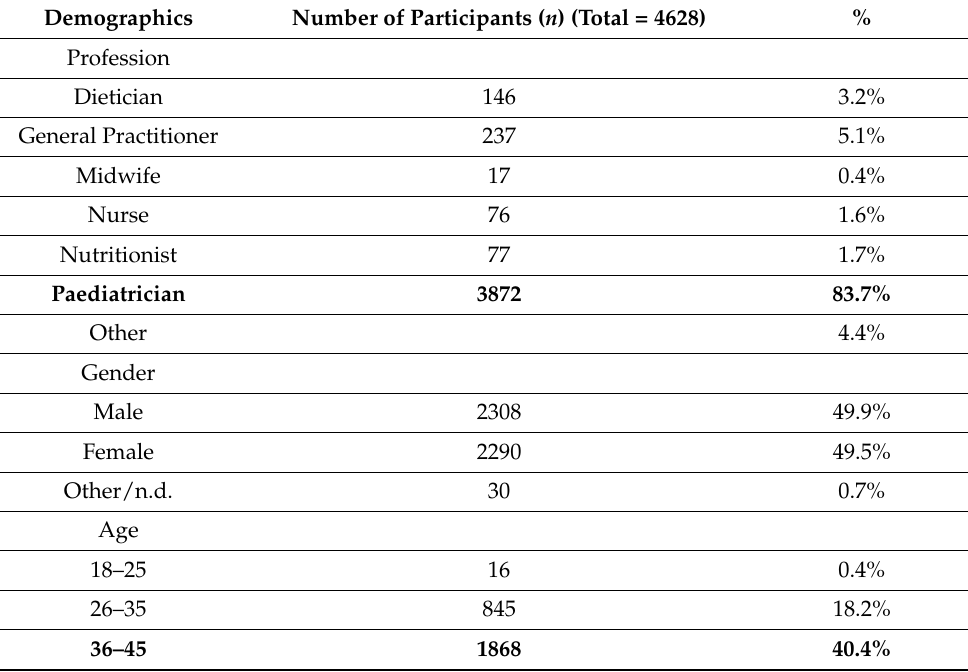
Table 1. Demographic characteristics of registered participants on the Early Nutrition Specialist Programme (ENS) e-learning